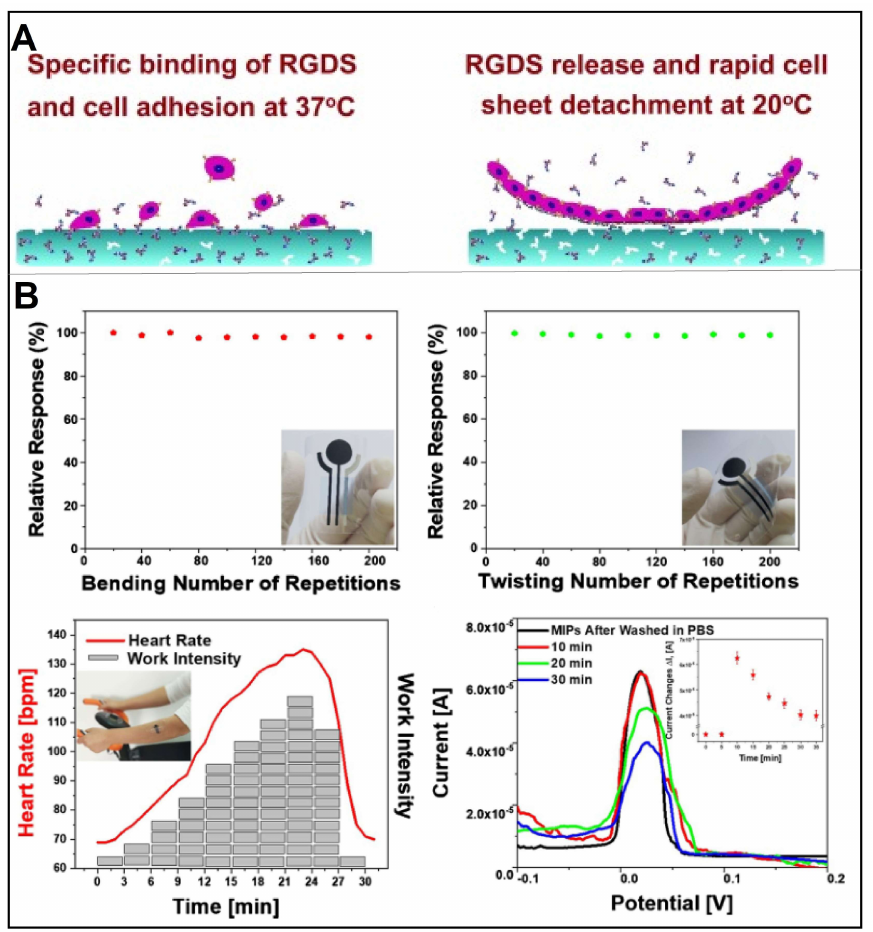
Figure 11. ( A ) Schematic diagram of a heat-responsive hydrogel layer for reversible cell adhesion and cell sheet harvesting using RGDS peptide blotting. Reproduced with permission from